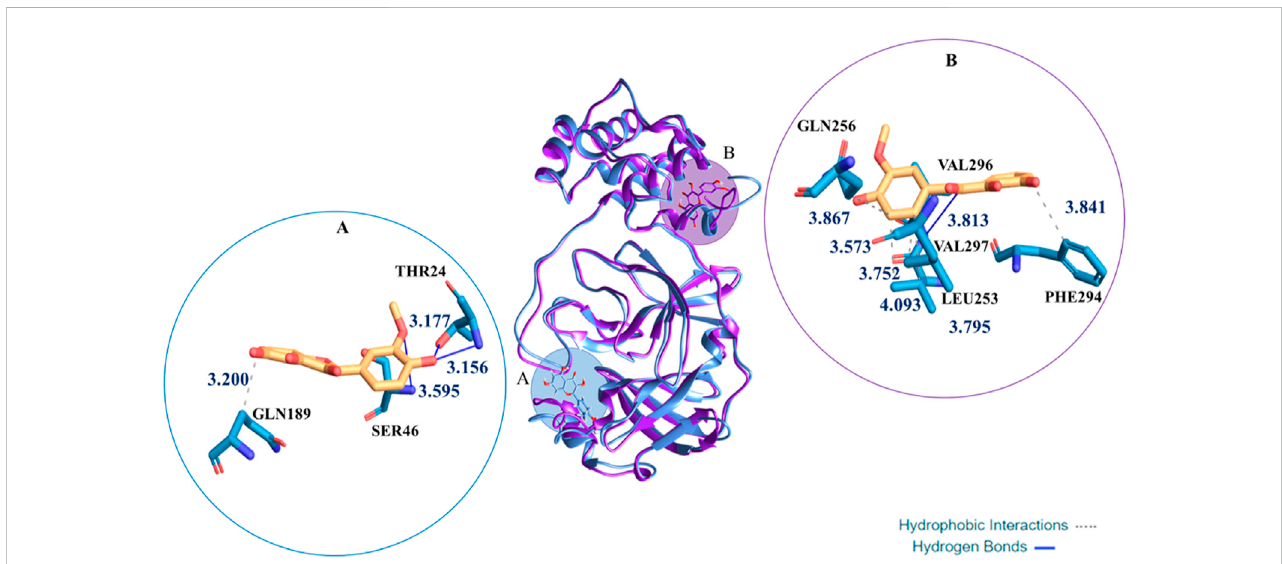
Superimposition of the most representative cluster from 100 ns of MD for the M pro :H 4 Iso and M pro :H 3 Iso − . In round windows complexes three- dimensional representation of the clustered structures with the residues that have crucial contacts with the compounds, in (A) (catalytic site) the H 4 Iso, in (B) (site #3) the H 3 Iso −